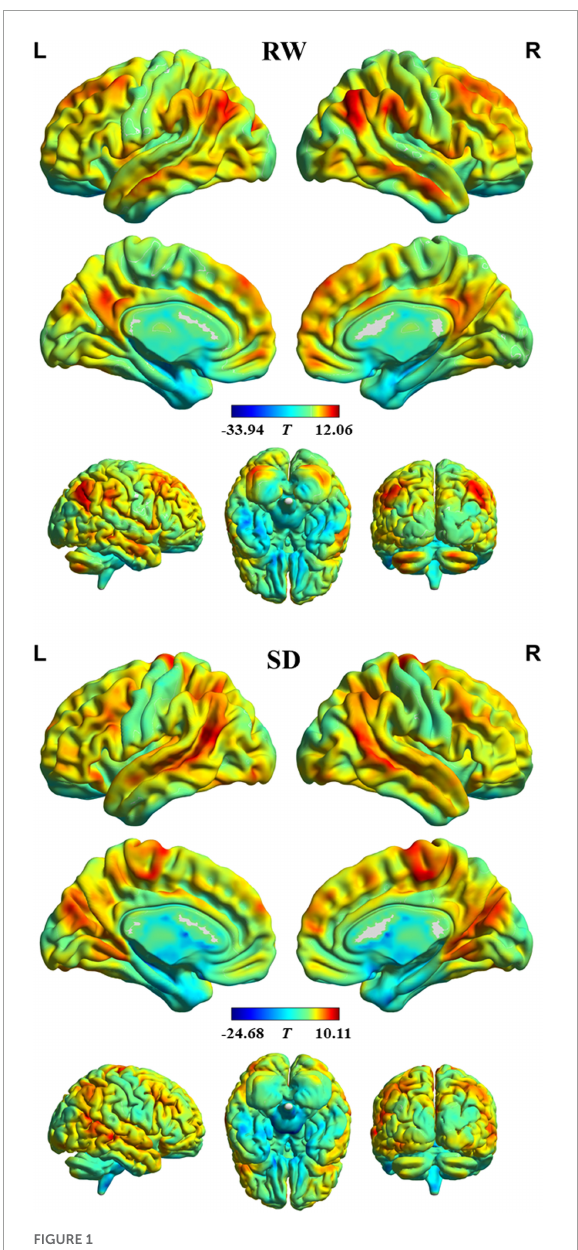
FIGURE1 Intrinsic functional stability (FS) profile within rested wakefulness (RW) and sleep deprivation